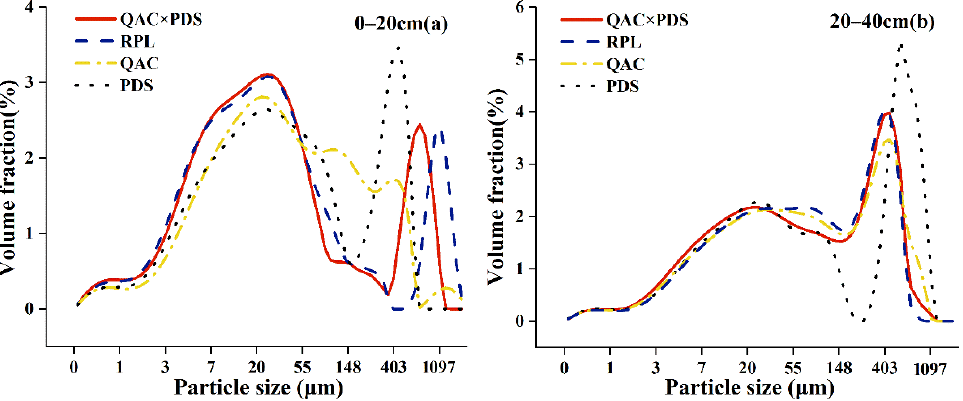
Figure 2. Frequency curves of soil particles for four vegetation restoration types. QAC × PDS is the mixed forest of Quercus acutissima – Pinus densiflora, RPL is the Robinia pseudoacacia forest, QAC is the Quercus acutissima forest, PDS is the Pinus densiflora forest. ( a ) represents the frequency curves of soil particles of 0–20 cm soil layer, ( b ) represents the frequency curves of soil particles of 20–40 cm soil layer.